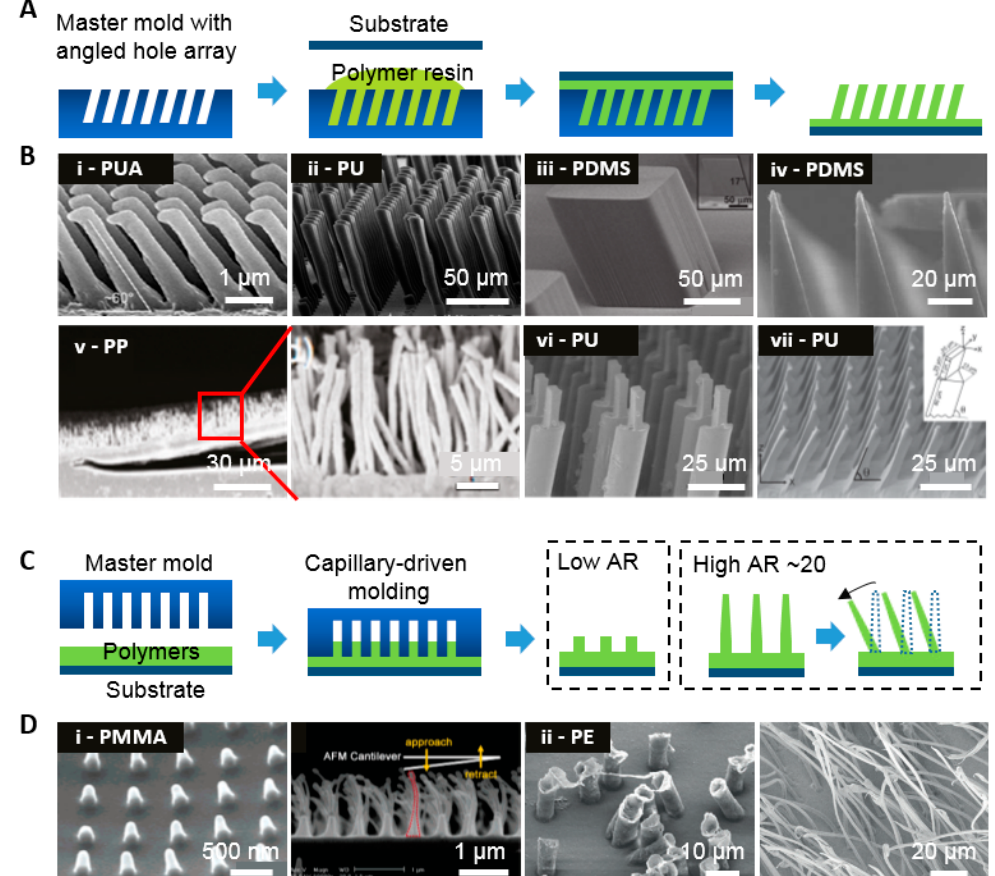
Figure 2. Schematic diagram and representative SEM images of the molding technique for fabricating tilted hairs. ( A ) Micro-/nanohairs obtained via soft molding on tilted slanted etched holes in the master mold; ( B ) various tilted hairs with (i) PUA, (ii,vi,vii) PU, (iii–iv) PDMS, and (v) PP. ((i) reproduced from [41], with permission from the National Academy of Science, Washington, DC, USA; (ii) reproduced from [42], with permission from the American Chemical Society; (iii) reproduced from [4], with permission from John Wiley & Sons; (iv) reproduced from [43], with permission from the Royal Society & Chemistry; (v) reproduced from [44], with permission from the American Chemical Society; (vi) reproduced from [45], with permission from the American Chemical Society; (vii) reproduced from [46], with permission from John Wiley & Sons); ( C ) Drawing of vertical polymeric hairs above the glass transition temperature by controlled adhesion between the polymer and mold; ( D ) (i) PMMA nanohairs and (ii) PE micro hairs obtained via nanodrawing methods. ((i) reproduced from [23], with permission from the American Chemical Society; (ii) reproduced from [49], with permission from IOP publishing Ltd.).